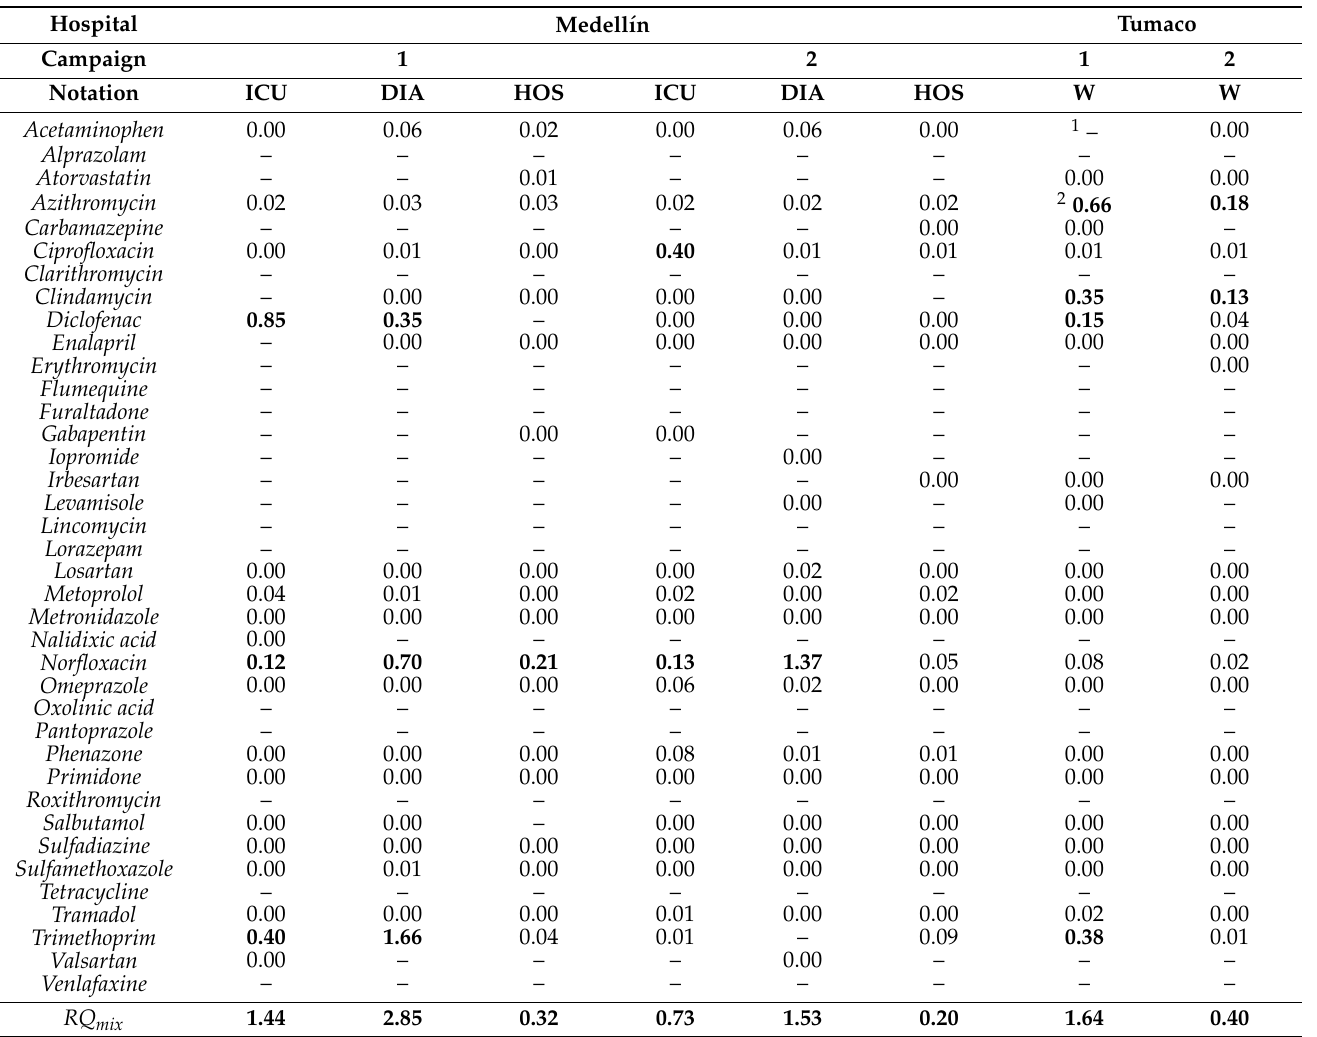
Table 4. Risk quotients (RQ p ) of the pharmaceuticals in the hospital wastewaters under Scenario b